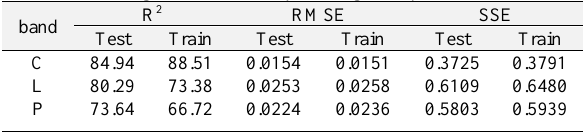
Name Feature Number